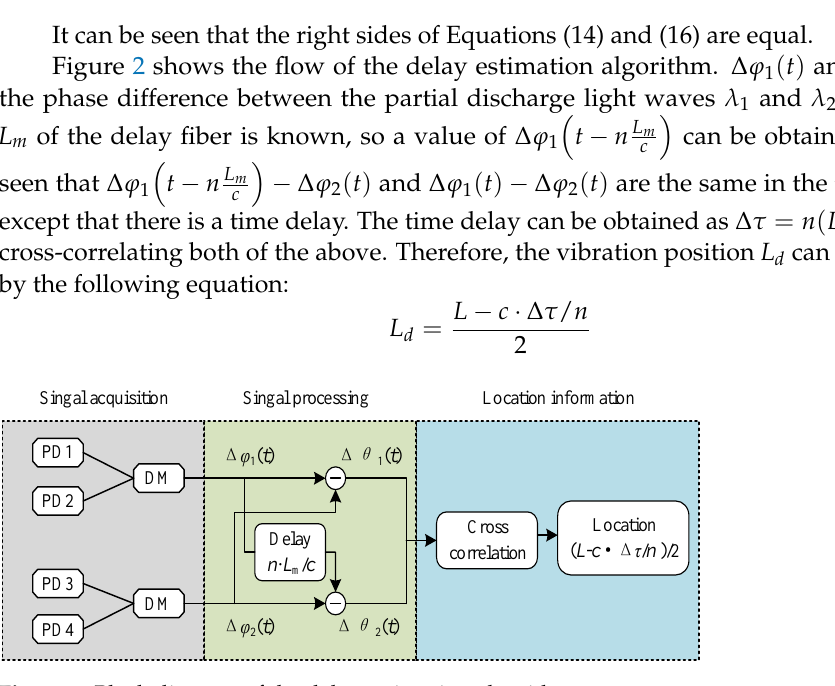
FUT Figure 3. Optical fiber sensing system for detecting interference signal. The wavelength λ 1 and the wavelength λ 2 are formed at OC. SLD: super bright light emitting diode; ISO: isolator; OC: 3 × 3 optical coupler; WDM: wavelength division mul- tiplexer; TDF: time delay fiber; PBS: polarization beam splitter; PD1-PD4: photodetector; DAQ: data acquisition. The wiring diagram of the dual Sagnac interferometer sensor is shown in Figure 3. The system consists of a sensing part and signal-processing part. A superluminescent di- ode (SLD) is used as the light source in this optical fiber sensing detection system, and its coherence length is several tens of micrometers. An optical isolator (ISO) is used to prevent reflected light from entering the light source and prevent it from interfering with the working state. A 3 × 3 optocoupler (OC) is used with a ratio of 1:1:1. The function of the wavelength division multiplexer (WDM) is to split or combine light. The delay fiber (TDF) is used to ensure that the phase changes of the two interferometers under the same inter- ference are different. The polarization compensation module (PCM) compensates for changes in the polarization state in the fiber and prevents polarization fading. There, pas- sive homodyne phase demodulation is realized without loading wave signal modulation in the fiber, based on the 3 × 3 OC closed Sagnac loop. PD1, PD2, PD3 and PD4 are used to detect the interference signal. The function of the data acquisition card (DAQ) is to con- vert the analog signal into a digital signal and transmit the data to the computer for data processing.